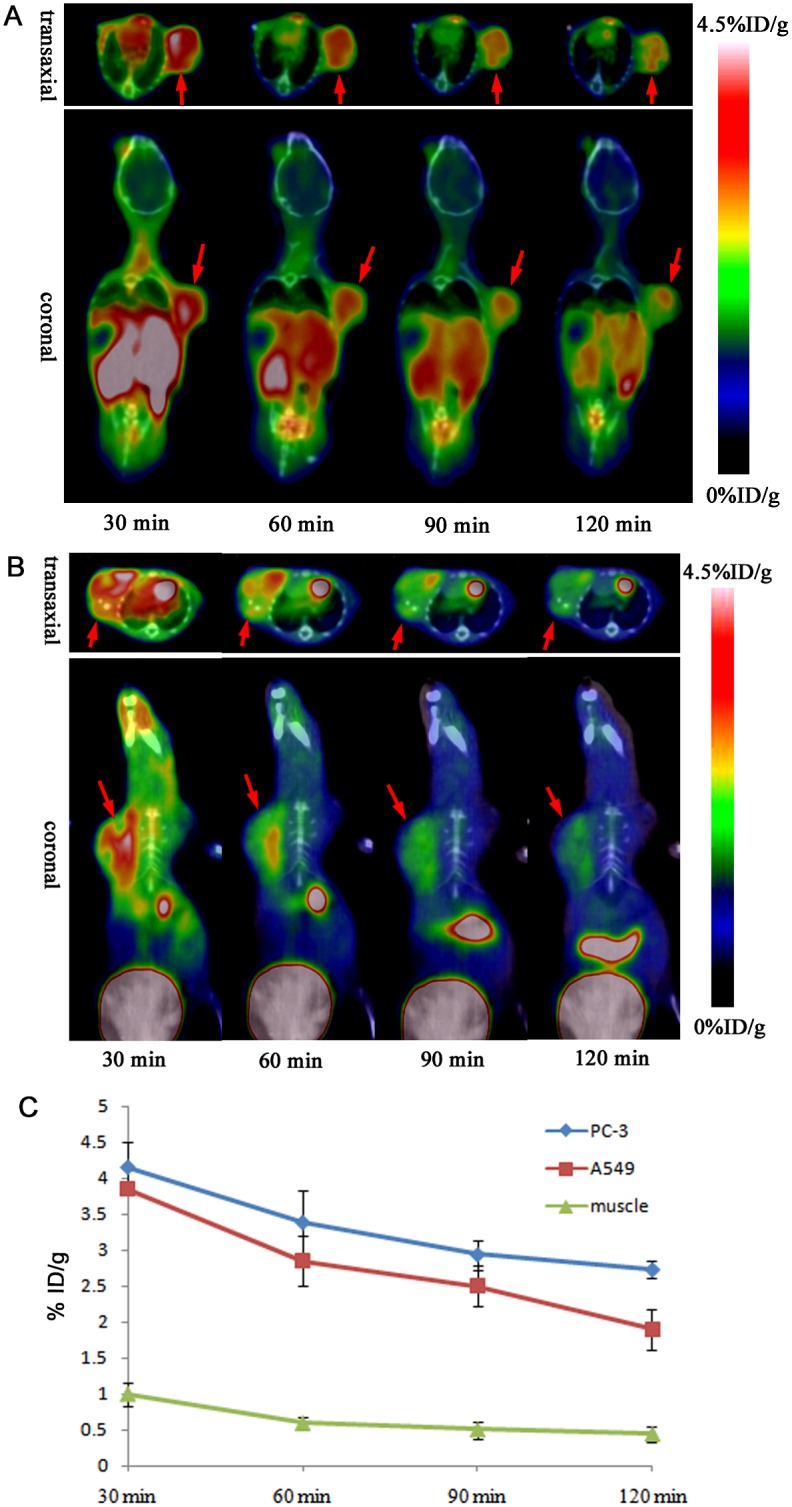
Small animal PET imaging and quantification.(A) MicroPET-CT imaging of PC-3 prostate tumor-bearing mice at 30, 60, 90, and 120 min after injection of 18F-FP-PEG2-β-Glu-RGD2. (The red arrows indicated PC-3 prostate tumor). (B) MicroPET-CT imaging of A549 human lung adenocarcinoma-bearing mice at 30, 60, 90, and 120 min after injection of 18F-FP-PEG2-β-Glu-RGD2. (The red arrows indicated A549 lung adenocarcinoma). (C) Time-activity curves of PC-3 prostate tumor, A549 lung adenocarcinoma and muscle after intravenous injection of 18F-FP-PEG2-β-Glu-RGD2.